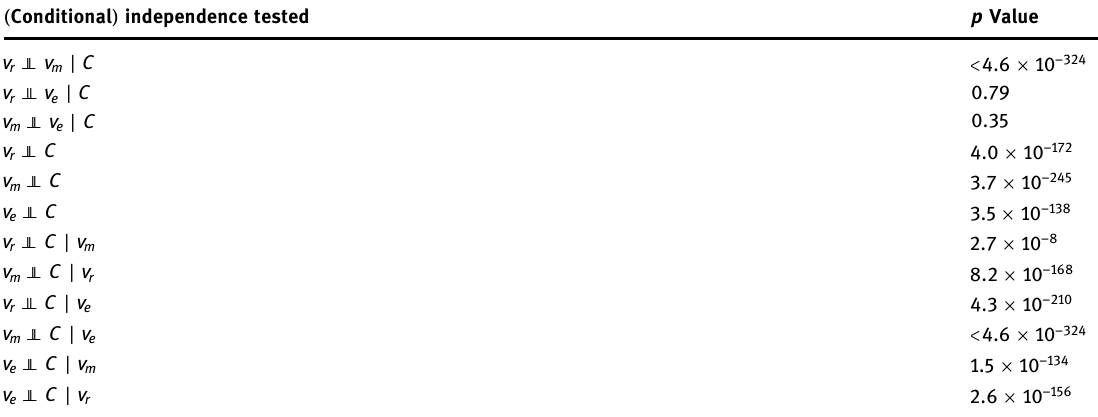
Speci fi cally, we report the p - values of Kendall ’ s test for partial correlation.